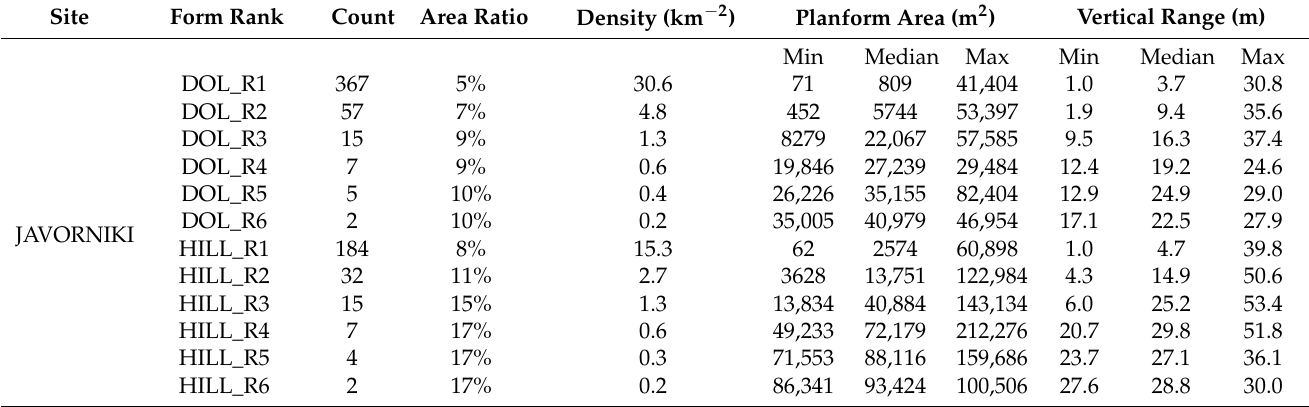
Table 1. Morphometric parameters (count, area ratio, density, planform area, and vertical range) of dolines and hills of the study areas. Site Form